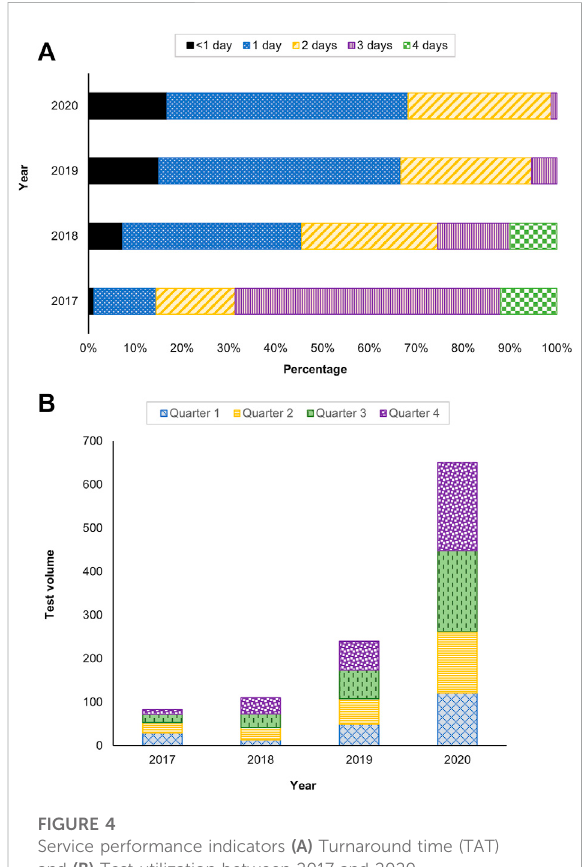
FIGURE 4 Service performance indicators (A) Turnaround time (TAT) and (B) Test utilization between 2017 and